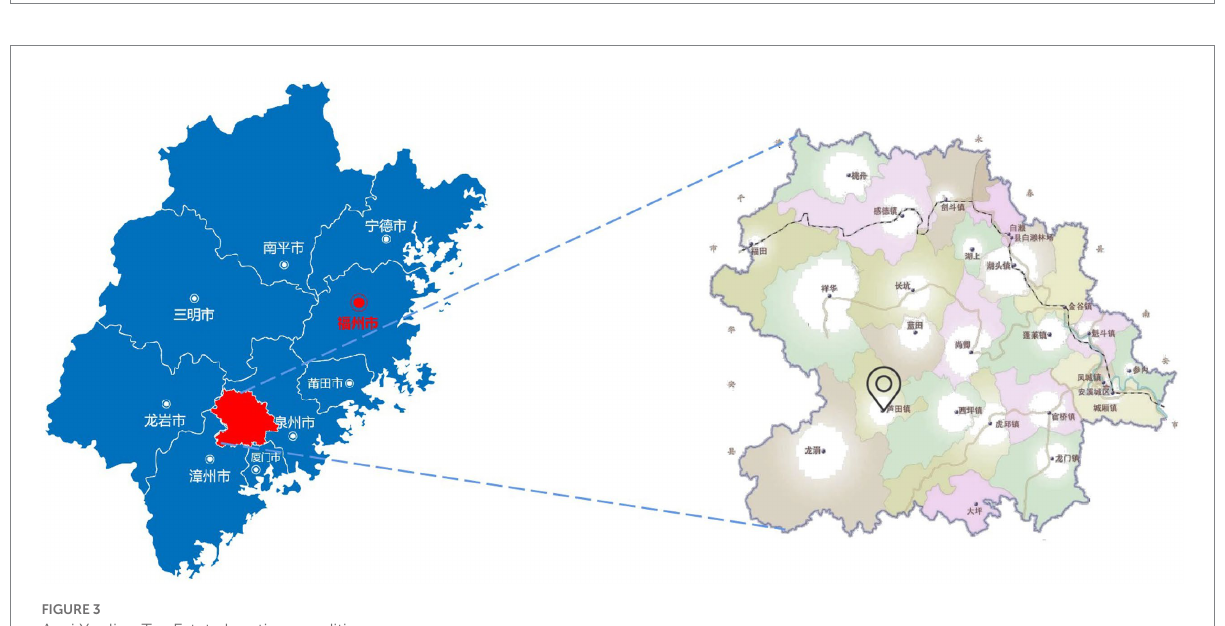
FIGURE 3 Anxi Yunling Tea Estate location